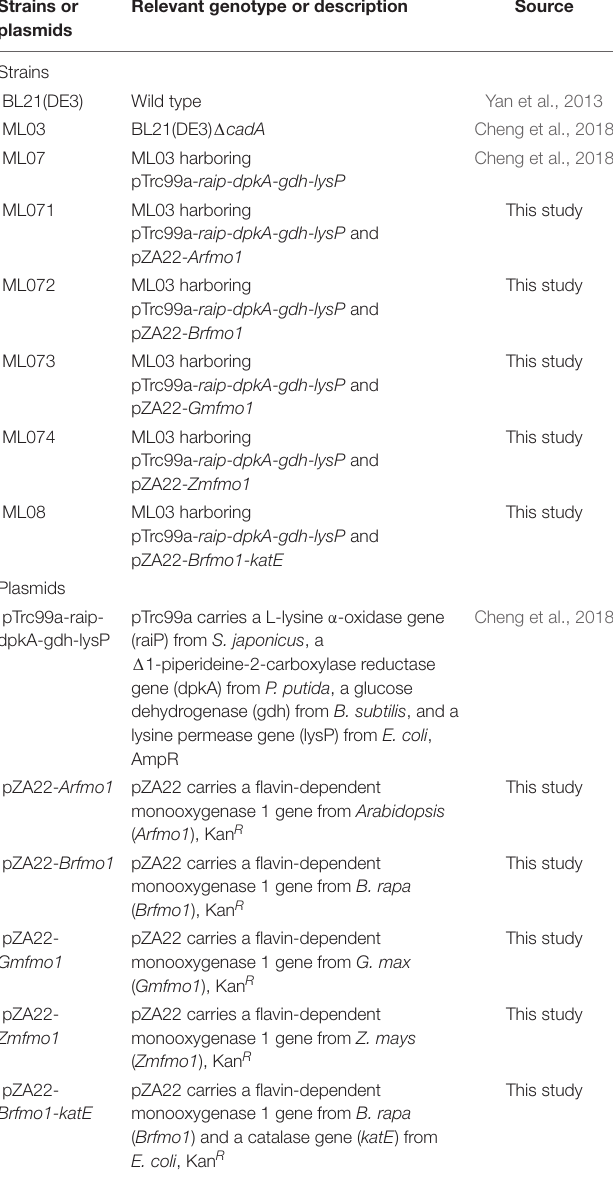
TABLE 1 | List of strains and plasmids used in this study. TABLE 2 | Production of N -hydroxy-pipecolic acid (NHP) from lysine by recombinant Escherichia coli ML071.